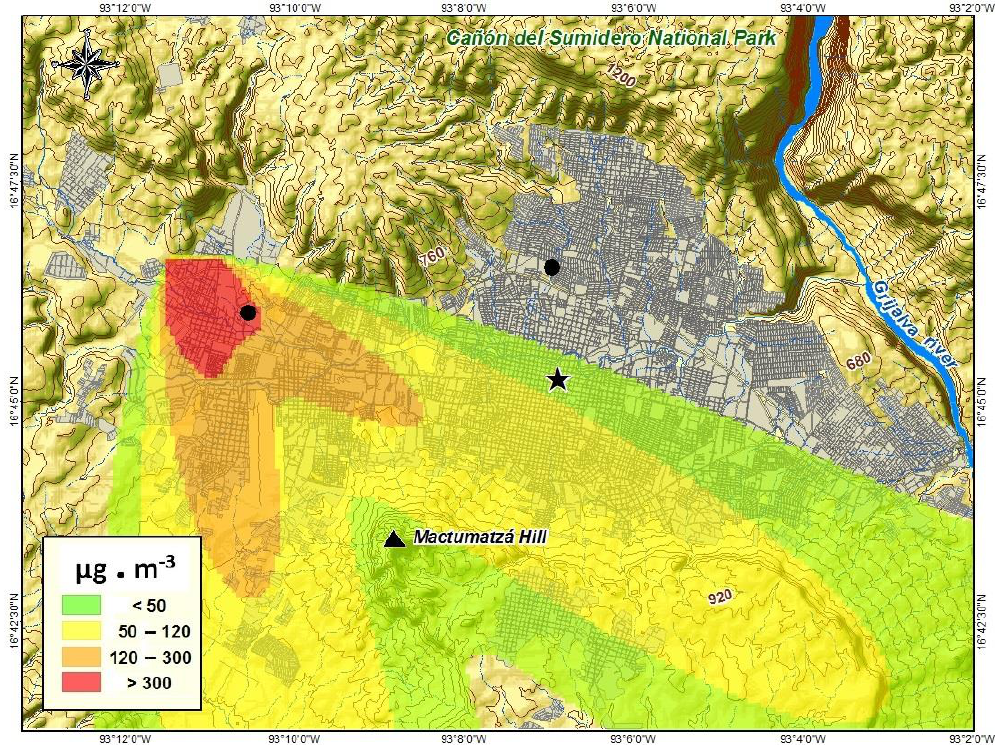
Figure 8. Dispersion of PM 10 dust particles over TGZ as simulated by the ISC3 model. Plume originating from Plan de Ayala during 13 March 2014. Points for Minivol monitoring PM 10 concentration are represented by ●. The central part of the city is represented by . The blue lines represent the presence of rivers and streams. The brown slight lines represent elevation in meters above sea level.